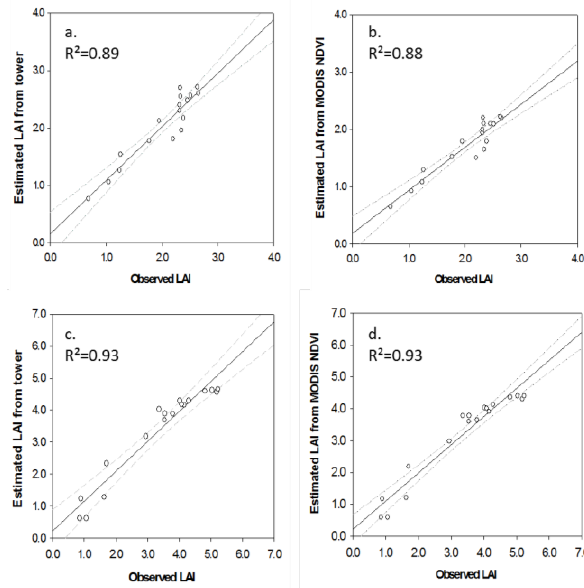
Figure 3. Correlations between estimated LAI and observed LAI for the early successional plots (a. and b.) and the intermediate successional plots (c. and d.) in the Santa Rosa National Park, Guanacaste. Dashed lines represent the 99% confidence